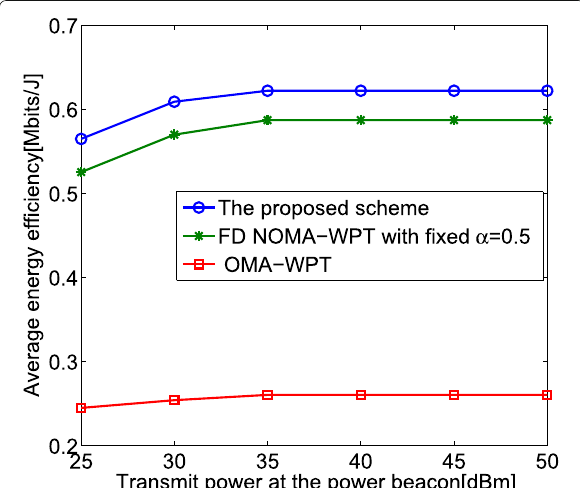
Fig. 4 Convergence of the proposed Algorithm2 under different number of transmit antennas at the BS